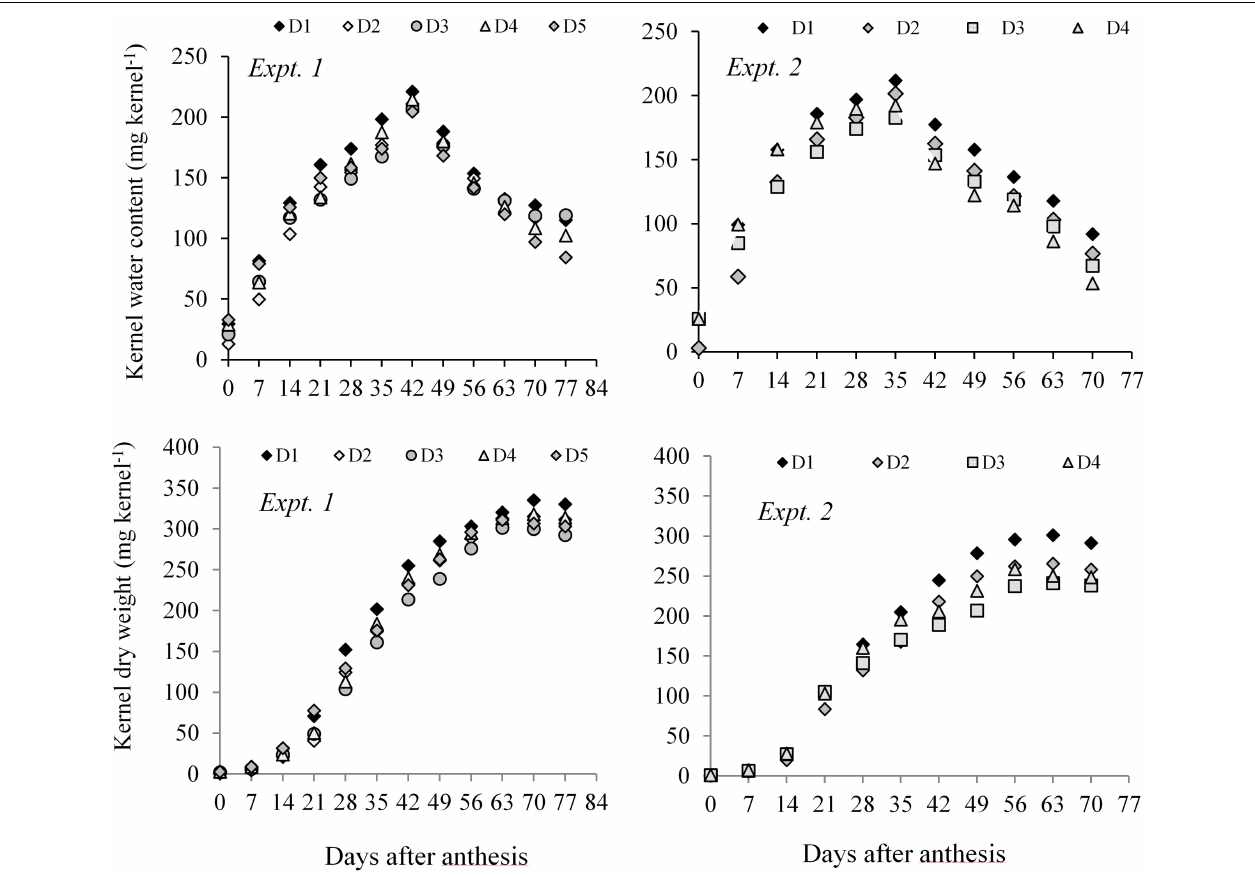
FIGURE 3 | Kernel water content and kernel dry weight of maize hybrids from anthesis to PM at 7 days interval under different water regimes averaged across hybrids in Expt. 1 and Expt. 2. In Expt. 1, D1–Control-soil water status maintained near FC, D2–Water deficit from V10 to V13, D3–Water deficit from V13 to V17 stage, D4–Water deficit from V17 to blister stage, and D5–Water deficit from blister to PM; In Expt. 2, D1–Control–soil water status maintained near FC, D2–Water deficit from V10 to anthesis stage, D3–Water deficit from anthesis to milk stage, and D4–Water deficit from milk to physiological maturity stage.